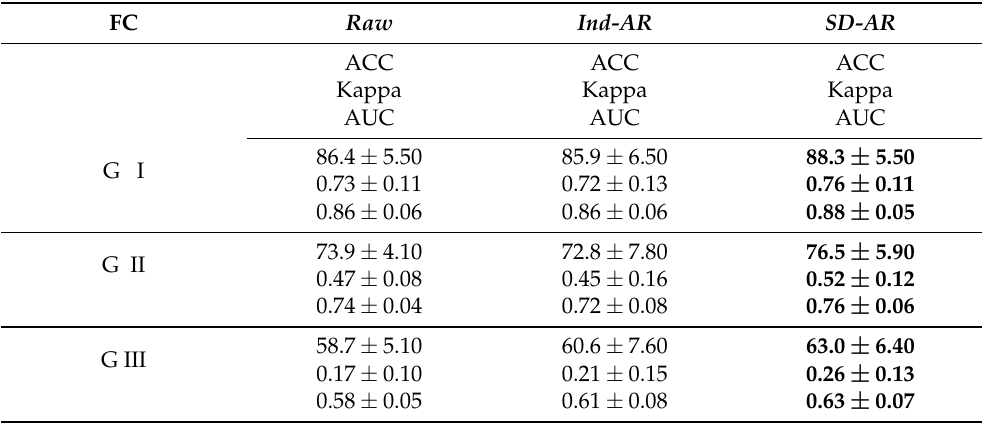
Table 3. The resulting performance of each training classifier scenario obtained by GFC for each considered group of skills in practicing the MI tasks. FC: Functional connectivity. Bold stands for the best results. FC Raw Ind-AR SD-AR ACC ACC Kappa Kappa AUC